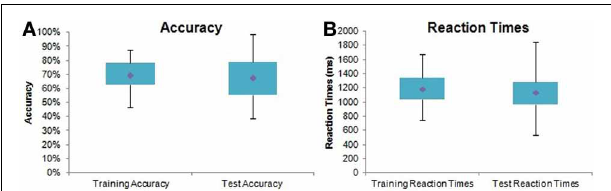
FIGURE 3 | Probabilistic selection task performance summary. Box plots with quartiles (upper values 75%, medians 50%, and lower values 25%). The whiskers show the range of the data, with no outliers. (A) Overall accuracy in training and testing for all subjects. (B) Overall reaction times in training and testing for all subjects.